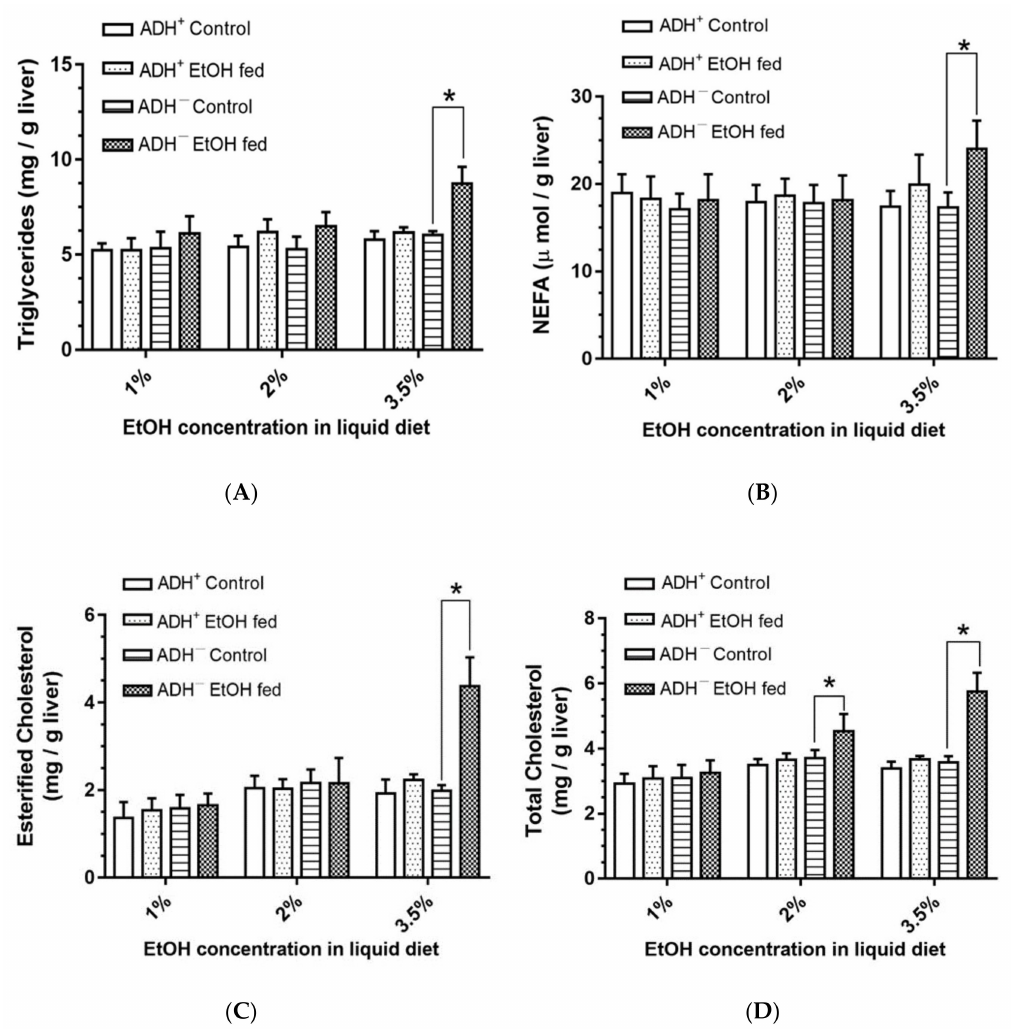
Figure 4. Triglycerides ( A ), non-esterified fatty acids (NEFA) ( B ), esterified cholesterol ( C ) and total cholesterol ( D ) levels in the livers of ADH − and ADH + deer mice fed 1%, 2% or 3.5% EtOH daily for 2 months. Values are means ± SEMs ( n = 5). * p ≤ 0.05 for EtOH-fed ADH − versus pair-fed control ADH − deer